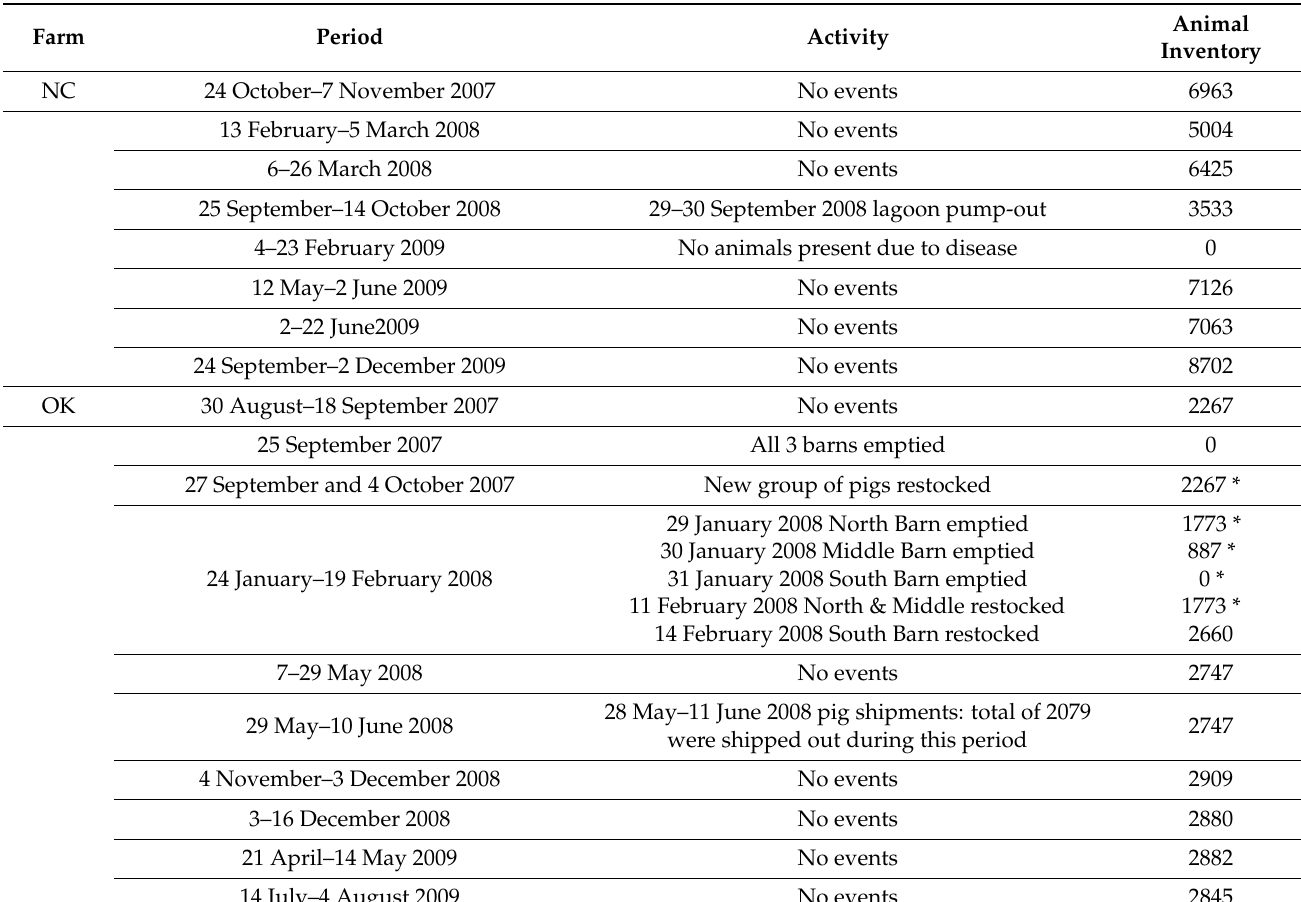
Table 1. Producer-supplied farm